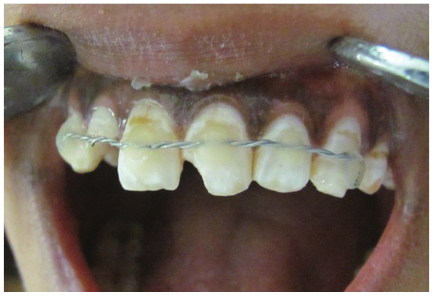
Figure 1: Diagnostic photo.